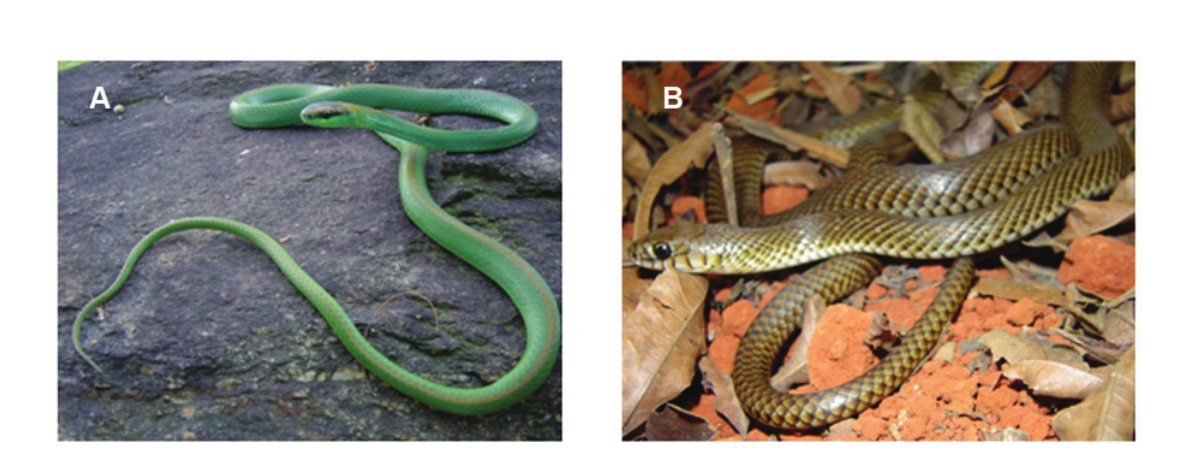
Figure 1. Adult individuals of ( A ) Philodryas olfersii and ( B ) Philodryas patagoniensis . Photos by Silvia R.